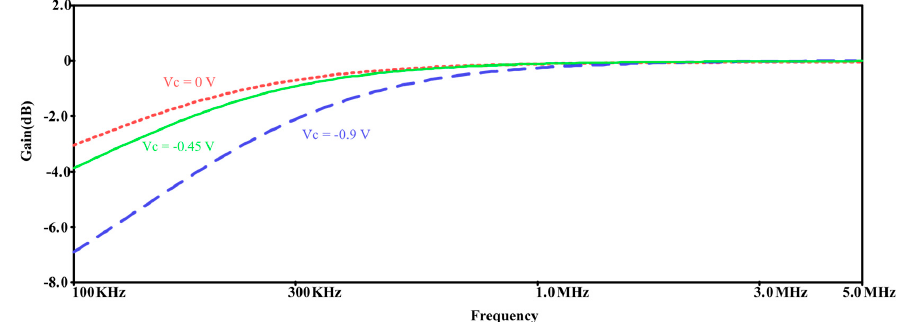
Figure 10. Frequency response of the high pass filter. In order to examine the time domain response of the proposed circuit, an input voltage with a peak-to-peak value of 0.4 V and frequency of 1 MHz is applied. For different values of control voltages of 0, − 0.45 V, and − 0.9 V, the value of the input current phase is − 101 ◦ , − 101.4 ◦ , and − 101 ◦ , respectively. The time domain responses are shown in Figure 11.